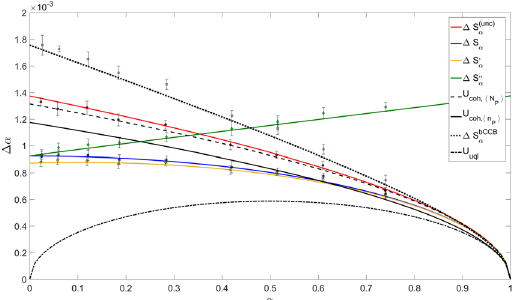
Figure 3. Uncertainty on α in function of the mean value of α . Four different estimators are considered. Solid lines are the theoretical curves, dashed and dotted lines are the limits corresponding to significant theoretical limits (see text for details), the markers are the experimental data. In this configuration measured efficiencies 4 are η P = η R = 0.76 and 〈 〉 ⋅ ~ N 50 10 P